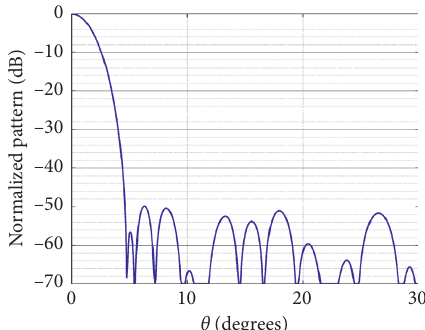
Figure 19: The two-way array pattern for N � 2 . 055. SLL �− 50.2 dB. M � 22, W 2